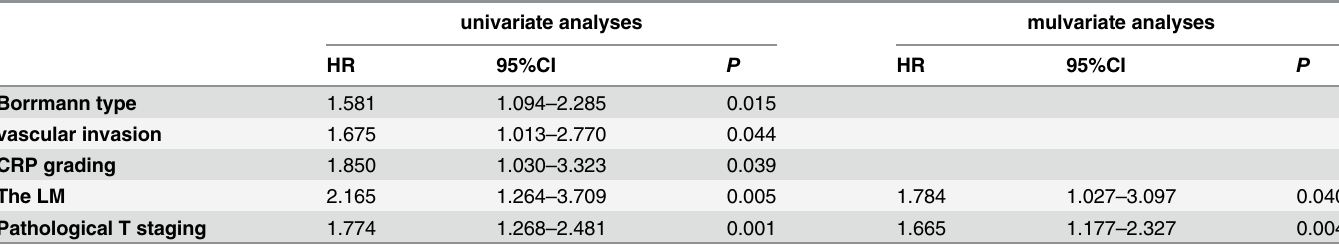
Table 5. The univariate and multivariate analyses of overall survival in these patients. univariate